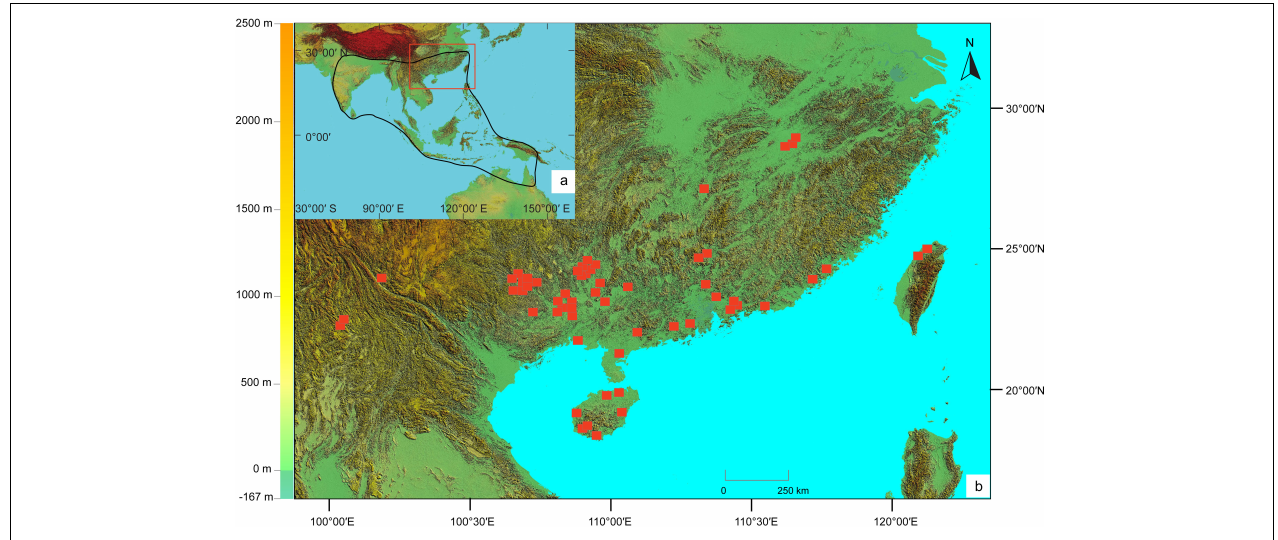
FIGURE 1 | Natural distribution of Oryza rufipogon . Inset shows full natural distribution. On the mainland the distribution is in Yunnan, Guangxi, Guangdong, Hunan, Jiangxi, and offshore on the islands of Hainan and Taiwan. The natural populations in Jiangxi and Taiwan are extinct due to habitat destruction. Based on Flora of China, Oryza , in volume 22, Huang and Schaal (2012) and Zhou et al.